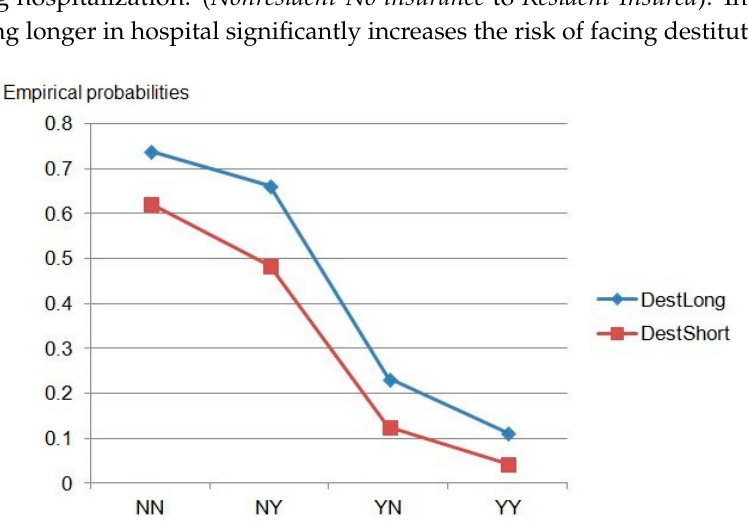
Figure 7. Changing probabilities of destitution for patients as a function of short versus long hospitalization. NN—non-resident & uninsured; NY—non-resident & insured; YN—Resident & uninsured; YY—Resident & insured.